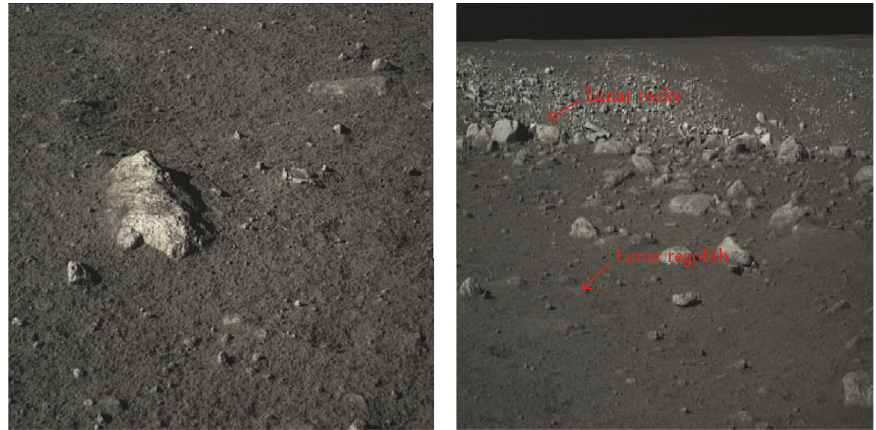
Figure 1: The photos were taken by the panoramic camera on the Yutu